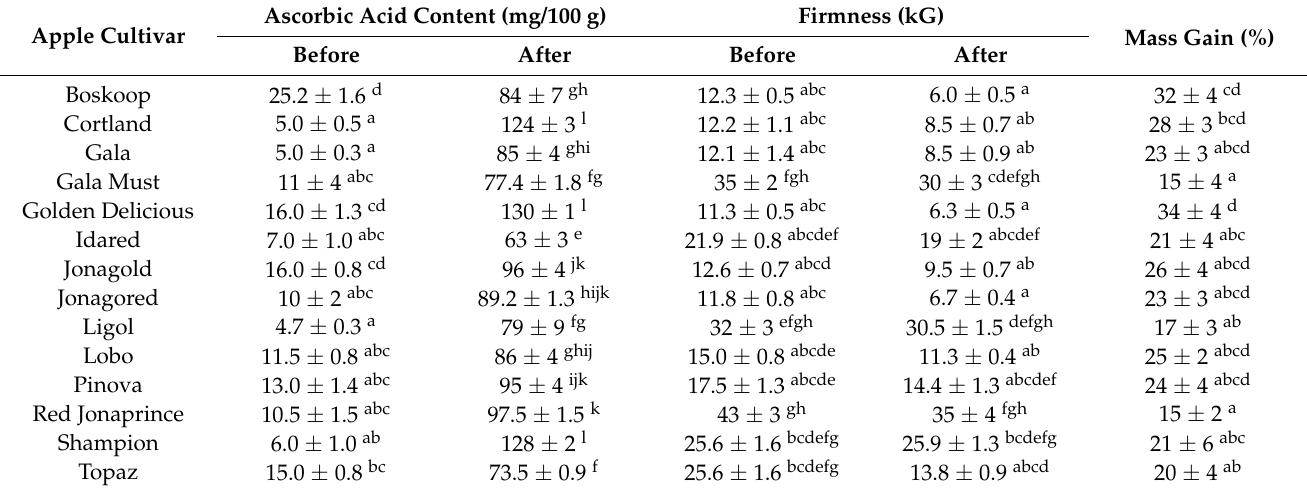
Table 1. Ascorbic acid content and firmness before and the after VI and mass gain of the apple cubes. Ascorbic Acid Content (mg/100 g) Firmness (kG) Apple Cultivar